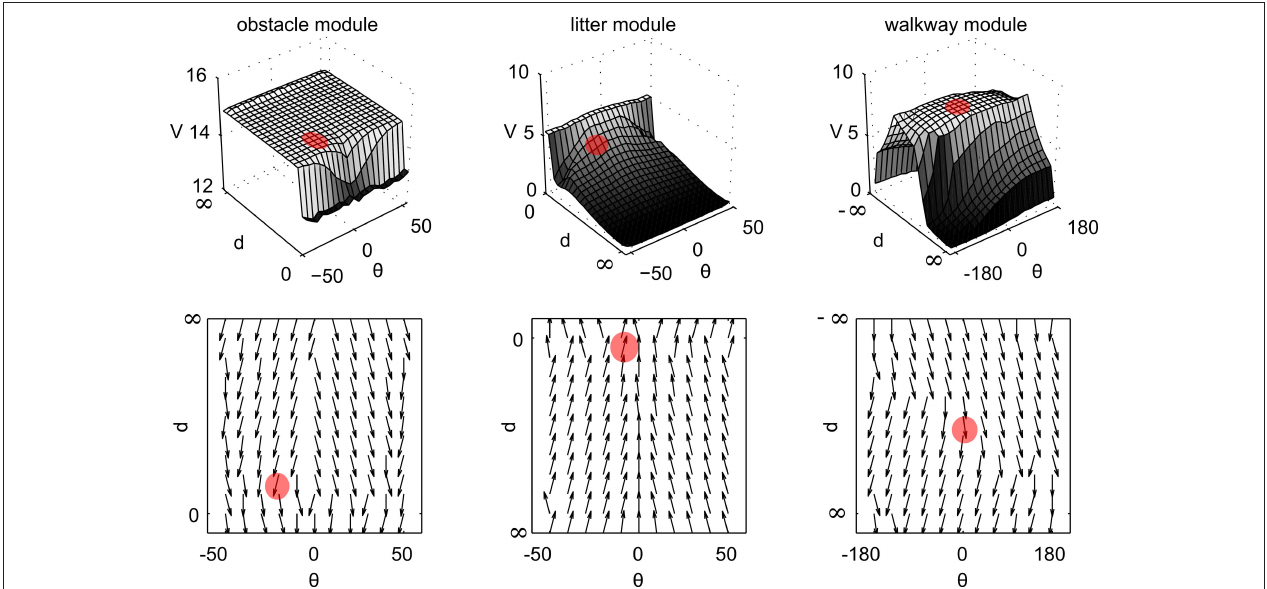
Figure 1 | Value functions (Top row) and their associated policies (Bottom row) for each of three modules. These functions for obstacle avoidance, litter collection, and sidewalk preference in left to right order have been learned by a